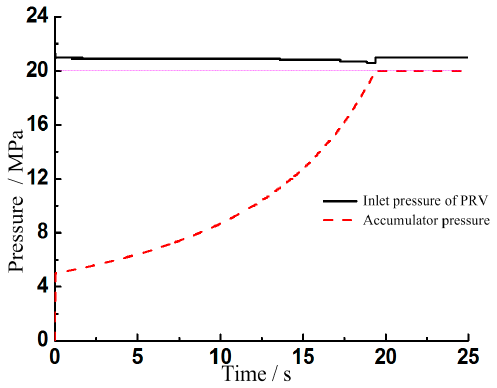
Figure 6. Pressures during the energy regeneration process.